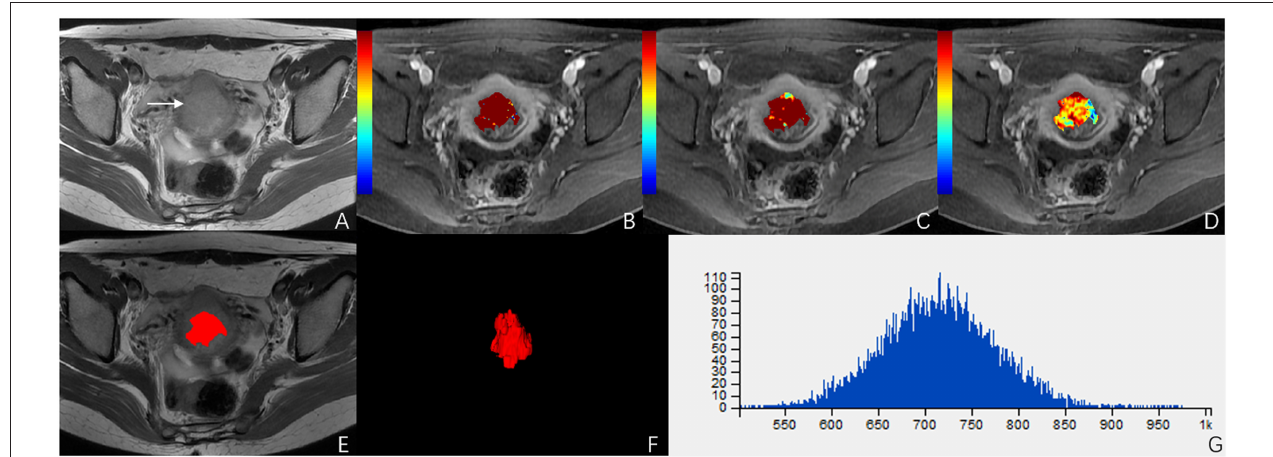
FIGURE 4 | A 51-year-old woman with stage IIB cervical cancer. (A) T2-weighted image (T2WI) shows a slightly hyperintense cervical mass. (B–D) K trans , K ep , and V e parametric maps are derived from DCE-MRI. The corresponding values are 0.577/min, 0.639/min, 0.694. (E,F) The volume of the tumor is drawn from T2WI. (G) Histogram map of the entire